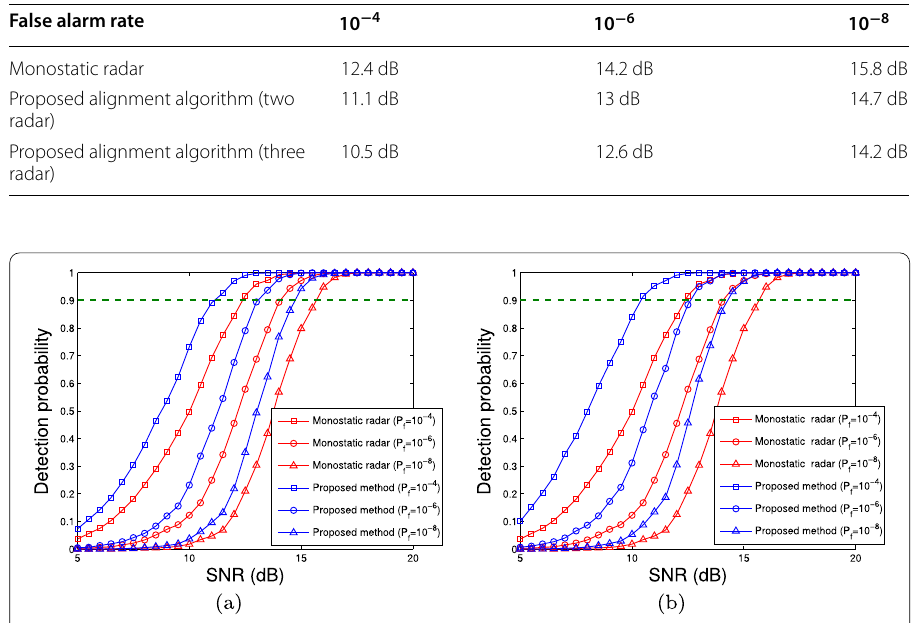
Fig. 14 The detection probability after alignment in different false alarm rate ( P f ) a proposed method by two radars compared with the monostatic radar b proposed method by three radars compared with the monostatic radar